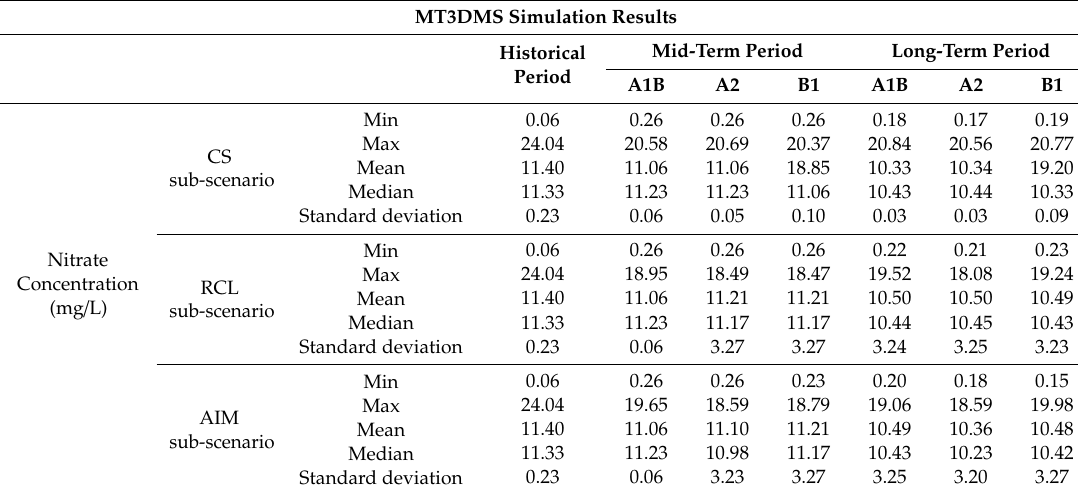
Simulation results from MT3DMS for water demand sub-scenarios of reservoir operation